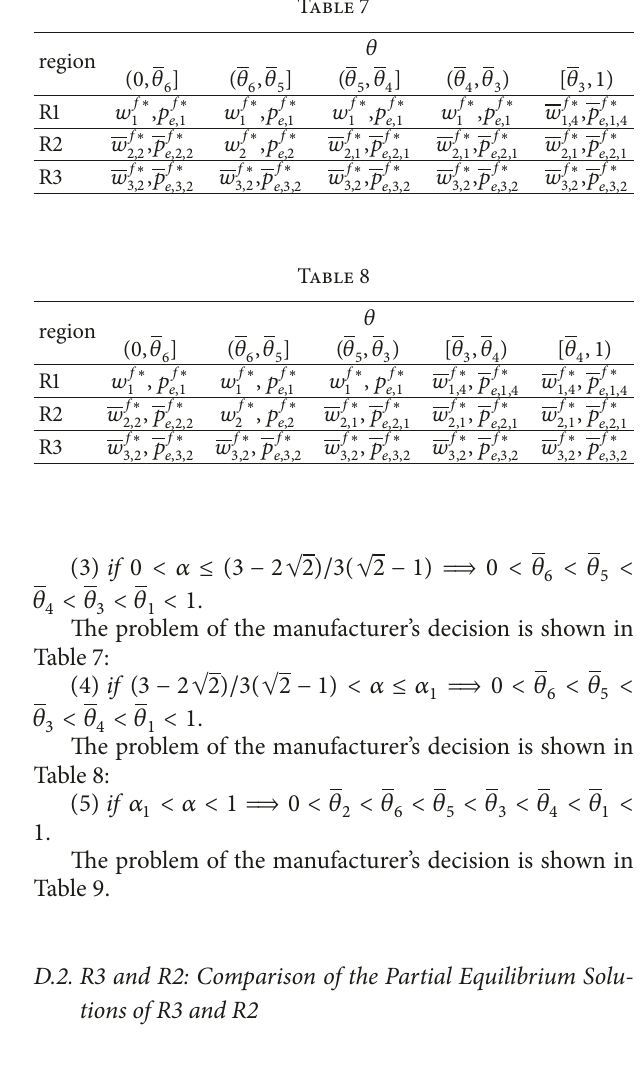
tions of R3 and